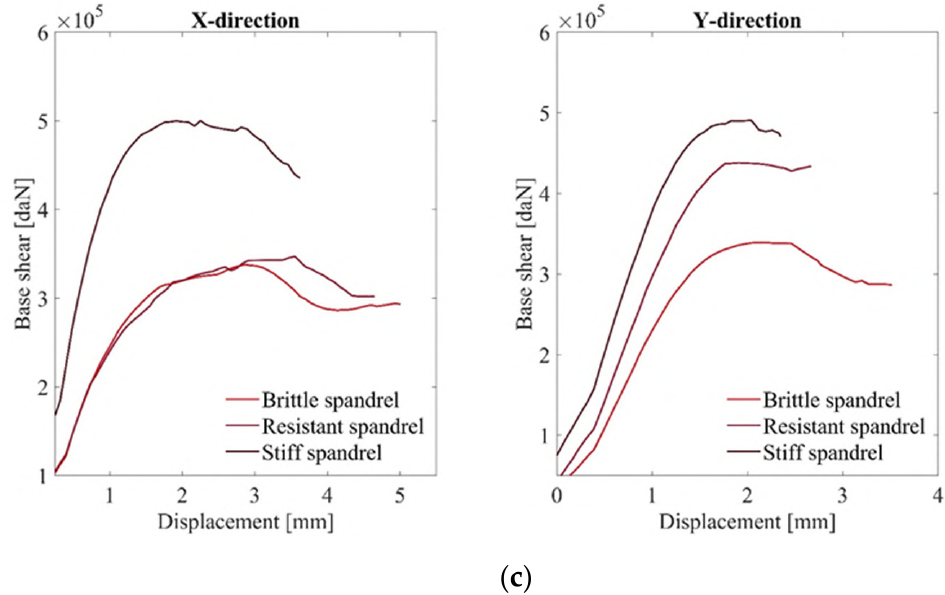
Figure 12. Push-over curves by varying: ( a ) the vertical structures; ( b ) the horizontal structures; ( c ) the spandrels typology.